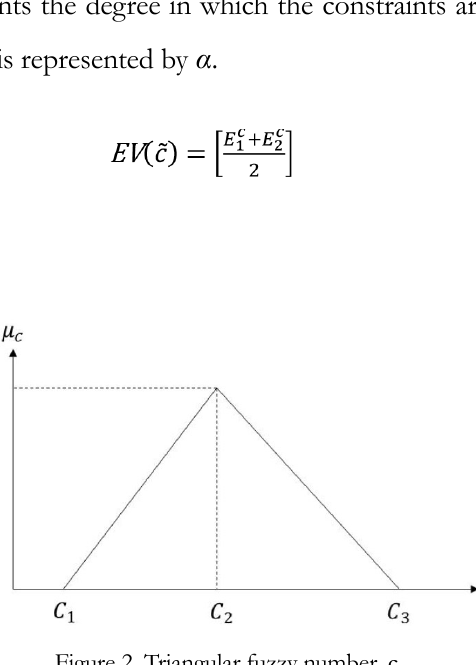
Figure 2. Triangular fuzzy number,